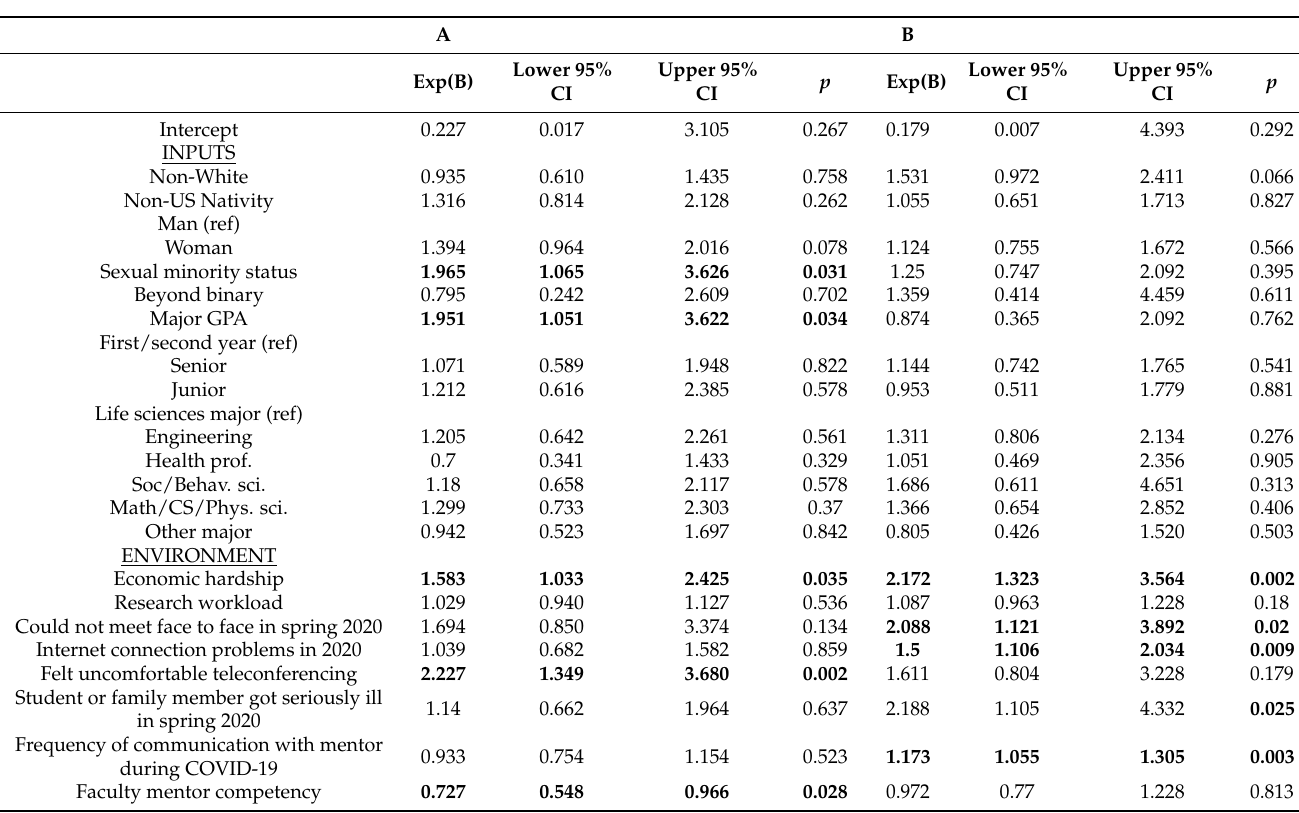
Table 3. GEE models predicting the odds of undergraduate researchers (A) lacking motivation for research and (B) experiencing a time